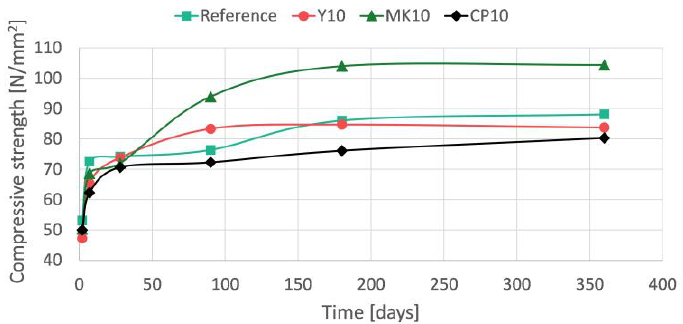
Figure 1. Compressive strength test results for all mixes over